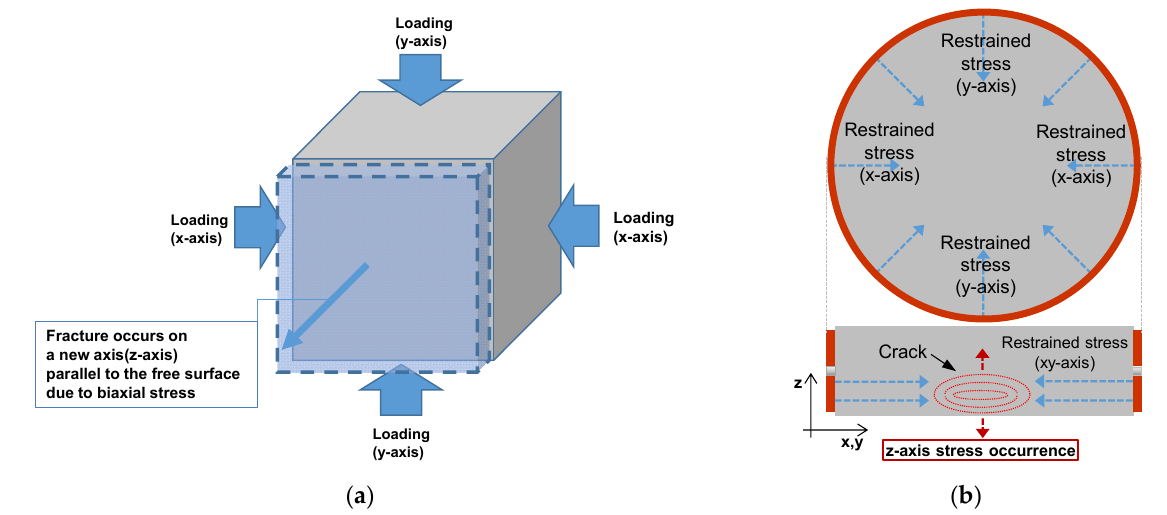
Figure 4. Restrained stress generated in concrete during heating. ( a ) New axis ( z -axis) stress generation. ( b ) z -axis stress of